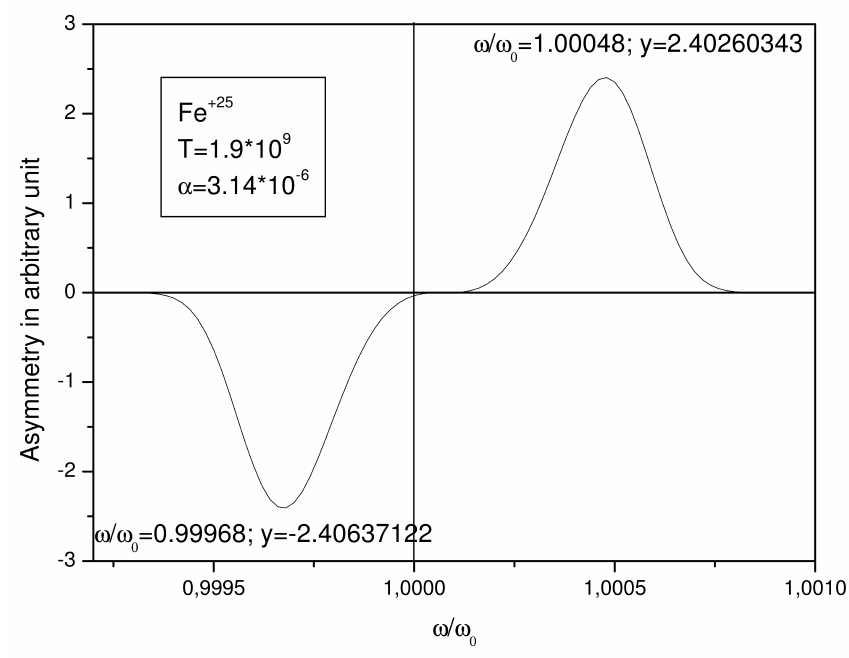
Figure 4. Asymmetry as defined by Formula (20) for Fe + 25 at T = 1.9 × 10 9